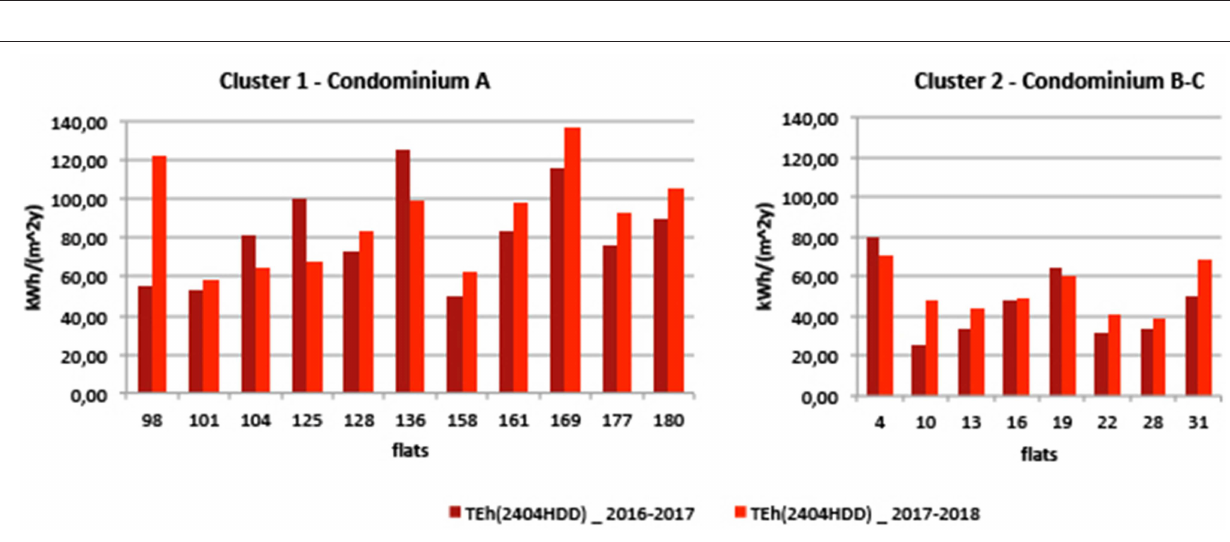
FIGURE 6 | Comparison of the thermal energy consumption of two clusters of similar dwellings in the two analyzed heating periods, normalized by the standard heating degree days and by the floor area of each